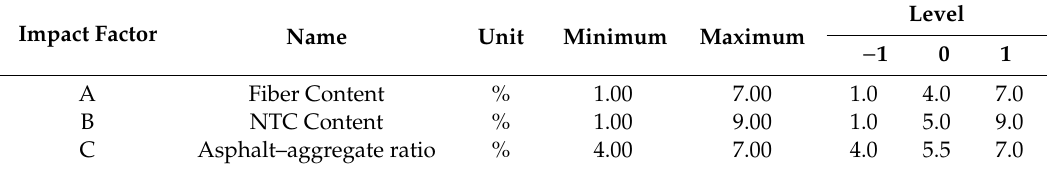
Figure 2. AC-13 gradation curve of the asphalt mixture. Table 6. Influence factor level and design.